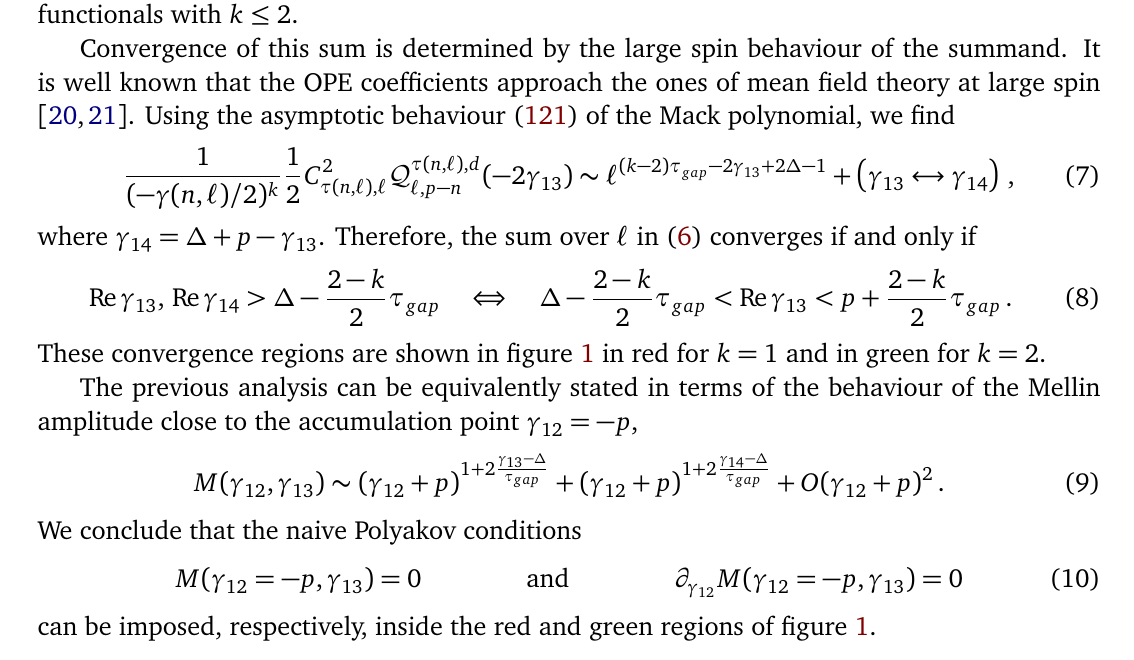
Figure 1: The Mellin-Mandelstam plane. The axis at 120 ◦ ensure that every point + γ + γ = ∆ . The accumulation points γ on the plane satisfies γ 12 13 14 n = 0,1,... are shown in blue. The region of convergence for sum rules with a func- tion F with a simple / double pole at one of these points is shown in red / green. Notice that the red region contains the green